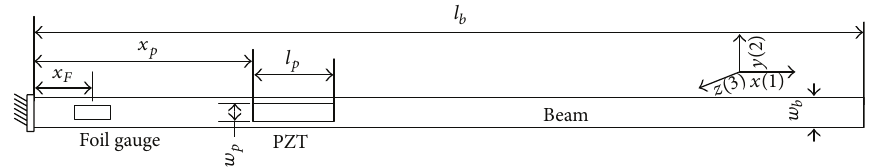
Figure 1: A cantilevered beam bonded with a piezoelectric